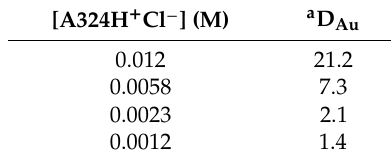
Table 1. Liquid-liquid extraction of gold(III) from 1 M HCl solutions by the ionic liquid A324H + Cl −